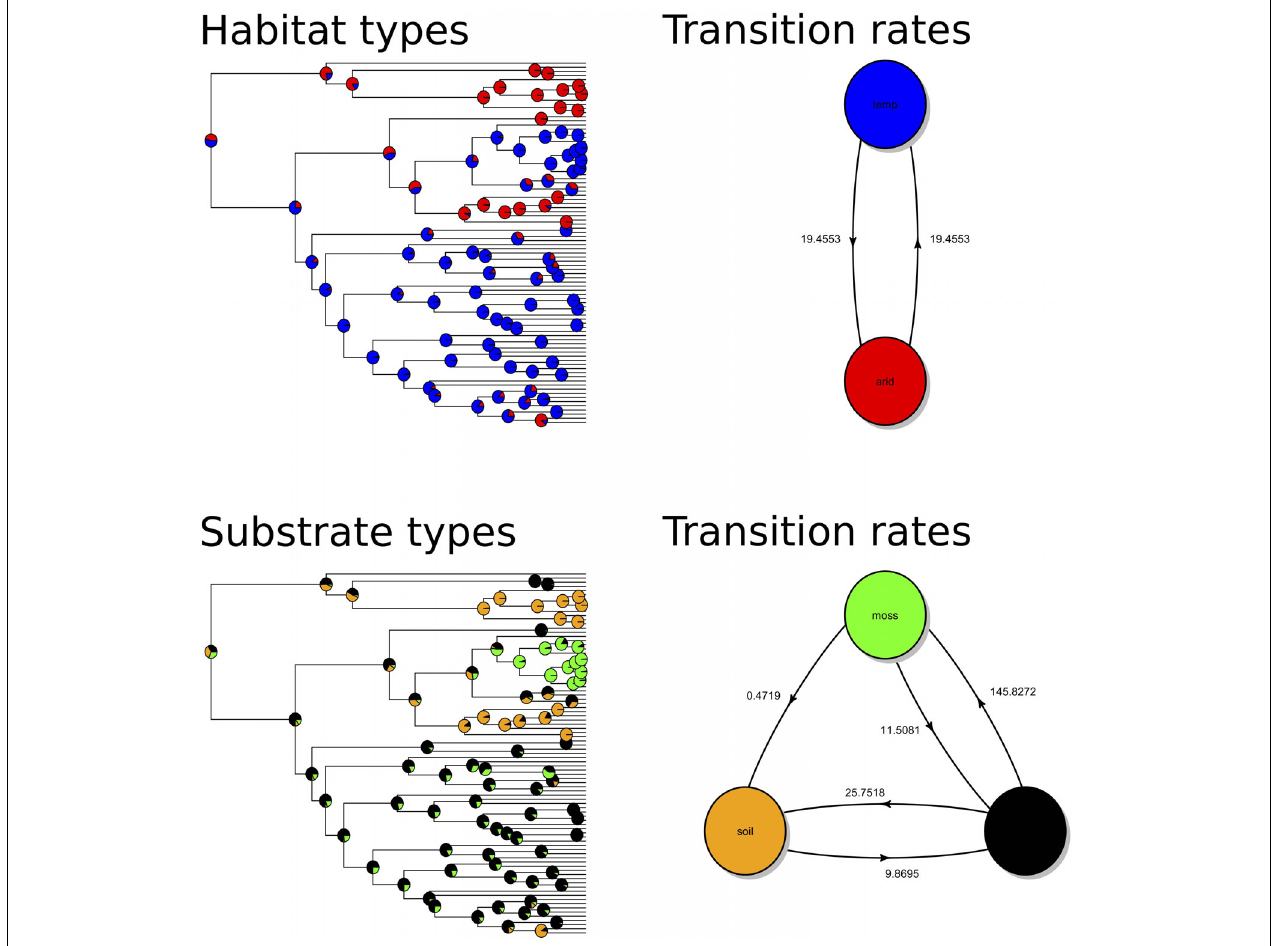
FIGURE 2 | Ancestral state estimations of habitat (upper panels) and substrate (lower panels) types and the corresponding maximum likelihood estimates of transition rates between states.